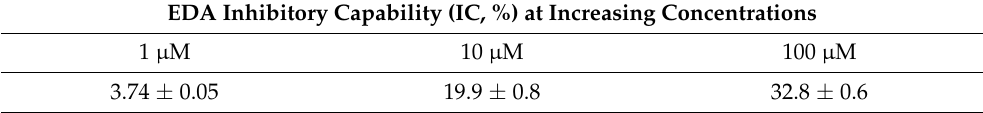
Table 4. Cytotoxicity of EDA on